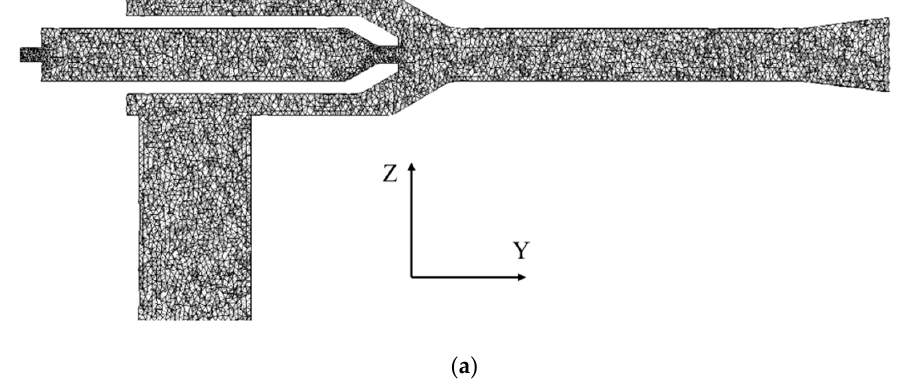
Figure 5. The grid refinement study. Table 2. Cases and their boundary conditions.